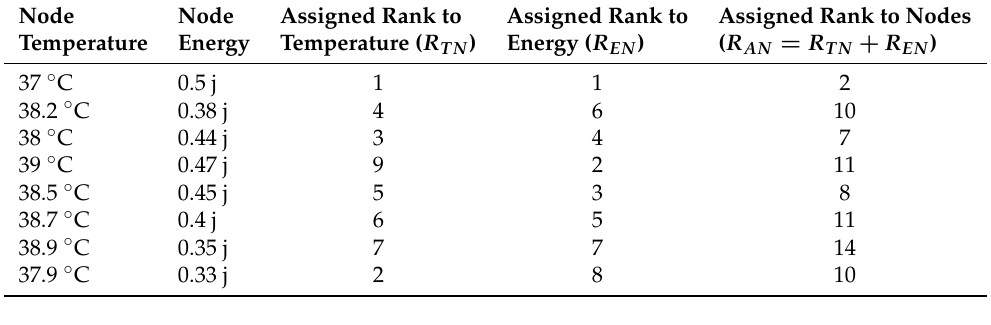
Table 3. Ranking of nodes.